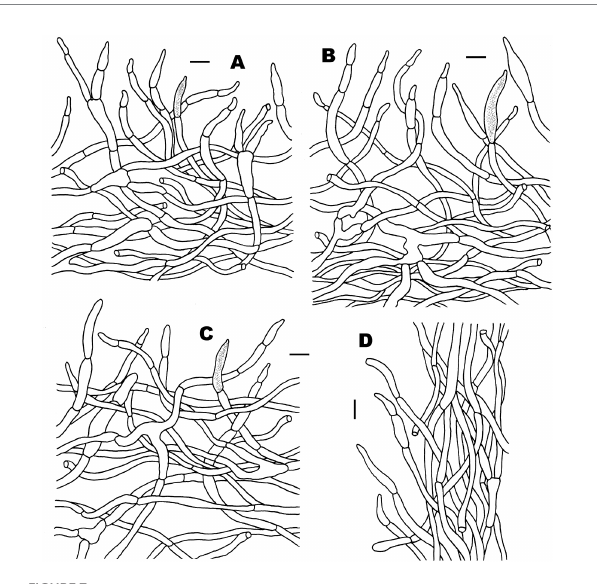
FIGURE 5 Microscopic features of Russula discoidea (FHMU4847, holotype). (A) Pileipellis at pileus center. (B) Pileipellis at the middle part between the center and margin of the pileus. (C) Pileipellis at pileus margin. (D) Stipitipellis. Scale bars = 10 μ m. Drawings by Y. X. Han.